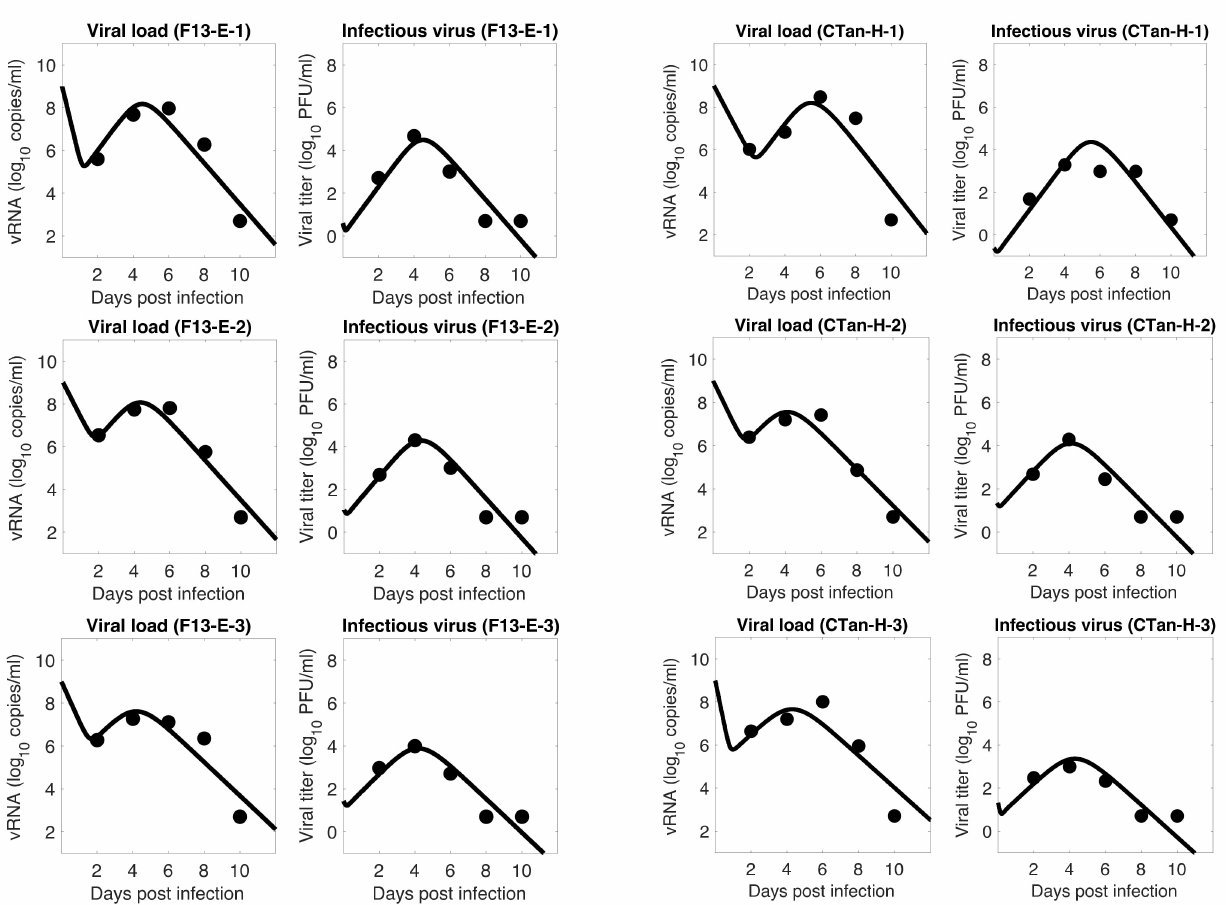
Figure 2. Model 2 fitting to the data. Prediction of the viral dynamics model 2 (solid line) along with the data (filled circle) containing the total viral load (RNA copies per mL) and the infectious virus titer (PFU per mL), collected from ferrets infected with F13-E SARS-CoV-2 and CTan-H SARS-CoV-2.